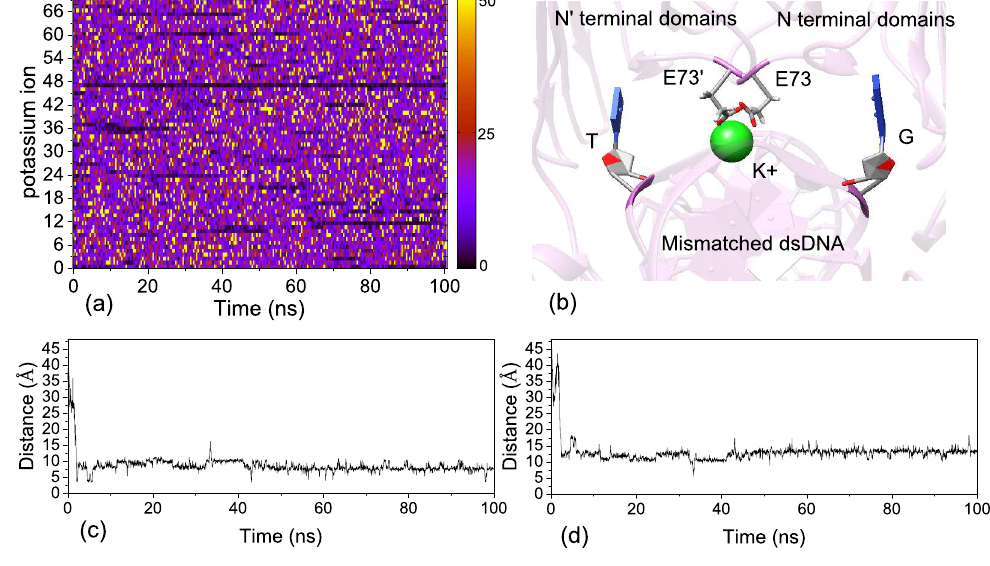
Figure 8. ( a ) The velocity changes of all K + ions for M20 during MD simulations. ( b ) The K + ion binding site in the dsDNA-bound system. ( c ) The distances between K + and mismatched base G8 during MD simulations. ( d ) The distances between K + and mismatched base T8’ during MD